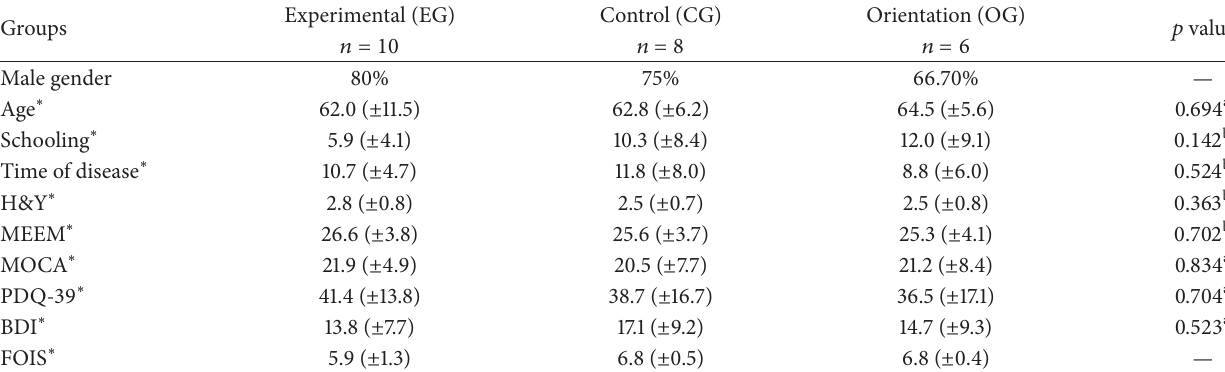
Table 1: Sociodemographic and clinical data.